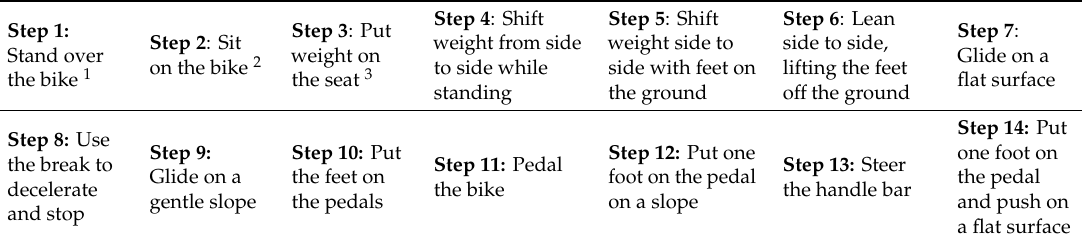
Table 1. An example of step-by-step observable behavioral objectives with exemplary criteria of success (Step 1–3) entitled, “You can bike!” from the Family Focused Tele-Intervention for Children with Developmental Coordination Disorder